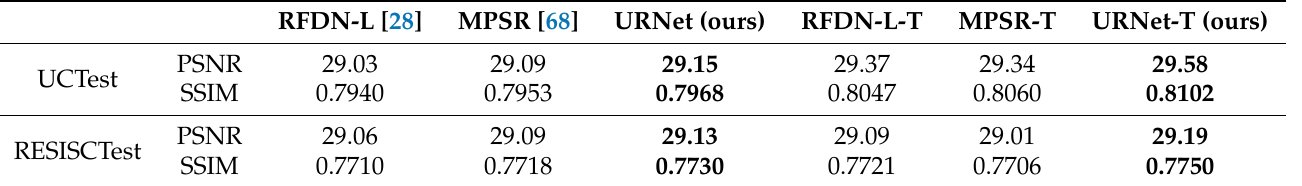
URNet-T: 39.5 G, in terms of parameters and FLOPs) and more likely to overfit on the training set. Table 7. The PSNR/SSIM of UCTest and RESISCTest with a scale factor of × 4. (*-T denotes using the pre-trained model.)